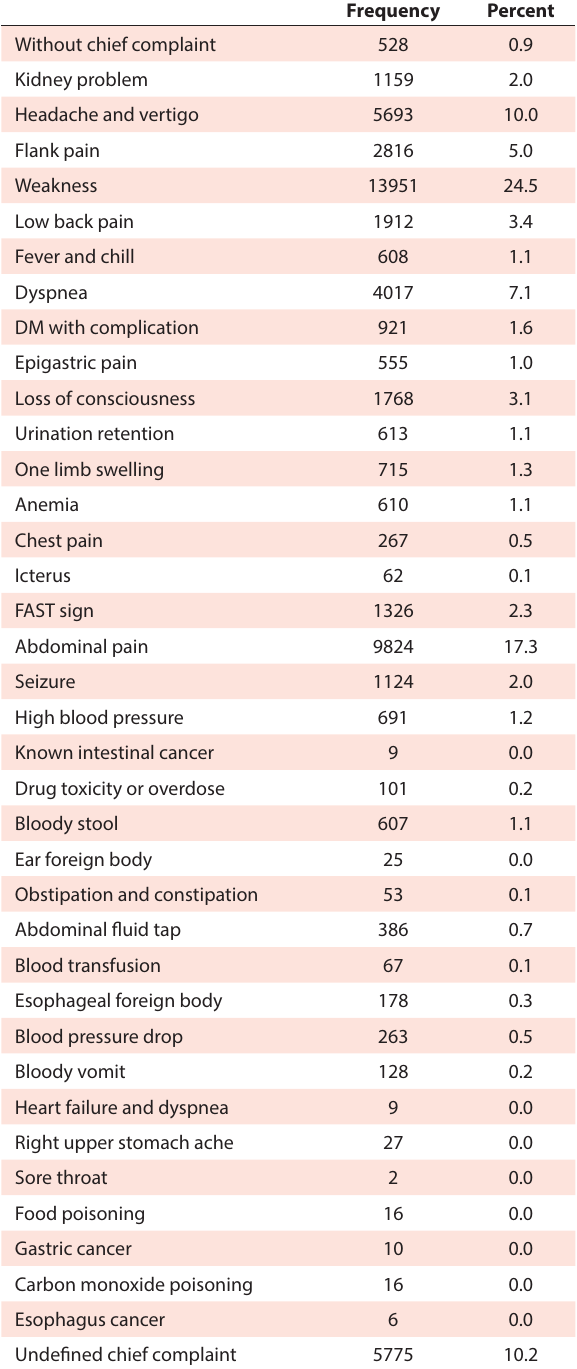
Table 1. Frequency of patients’ chief